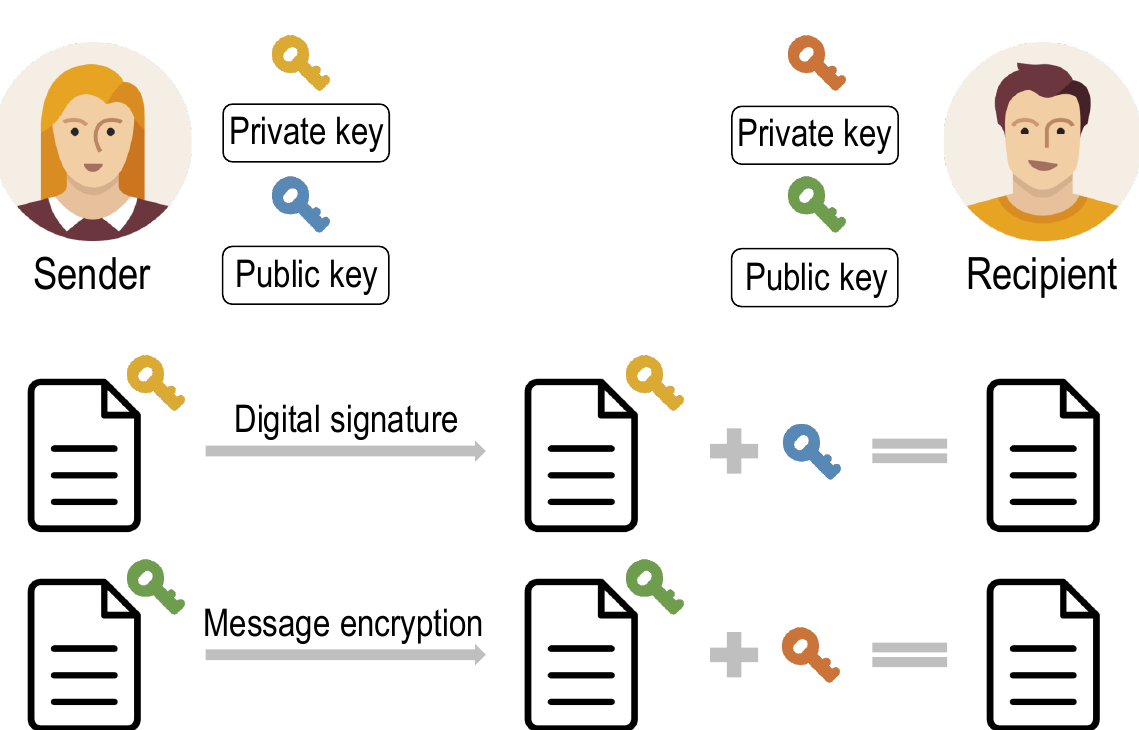
Figure 2. Message encryption and digital signature concepts in